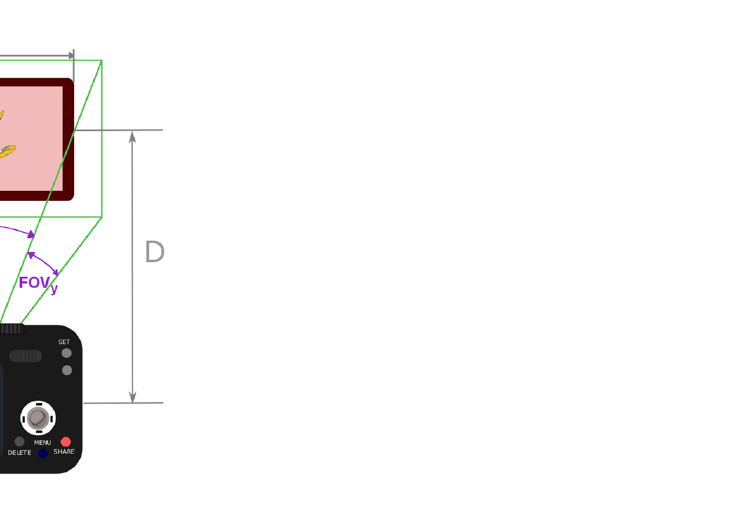
Figure 9. Image acquisition example. In this case, D is the distance between the camera (receiver) and the object (transmitter), d x and d y are the horizontal and vertical distances in the real